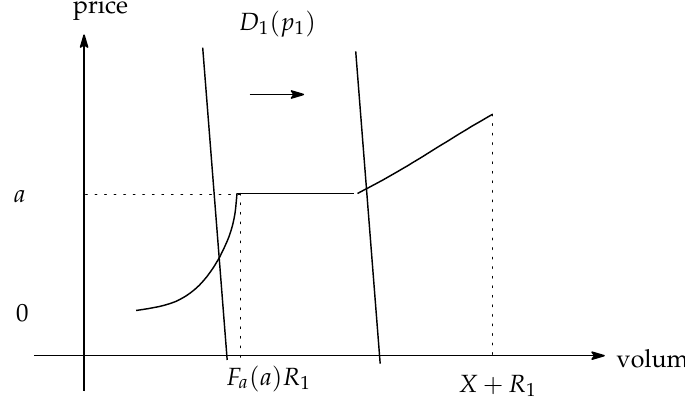
Figure 5. Date 1 Market Equilibrium without Speculative Trading (Authors’ own drawing) Figure 5. Date 1 market equilibrium without speculative